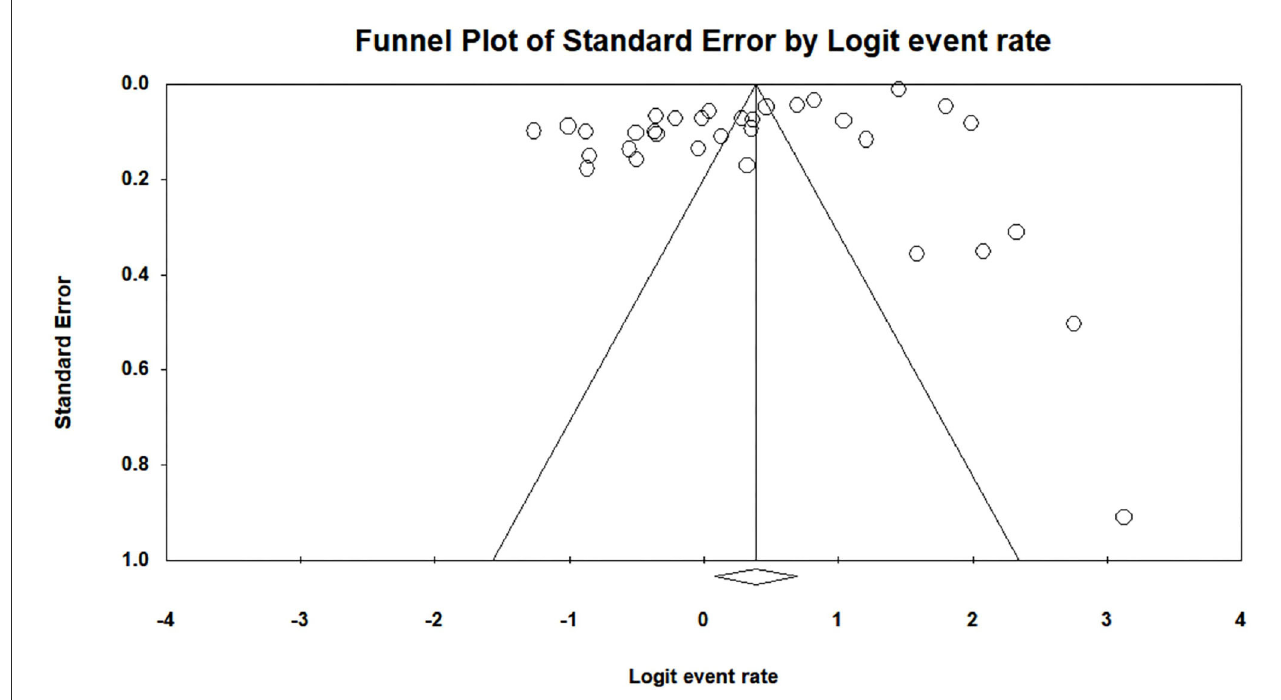
FIGURE2 A funnel plot assessing publication bias of satisfaction with online education among students before and after the COVID-19 outbreak.